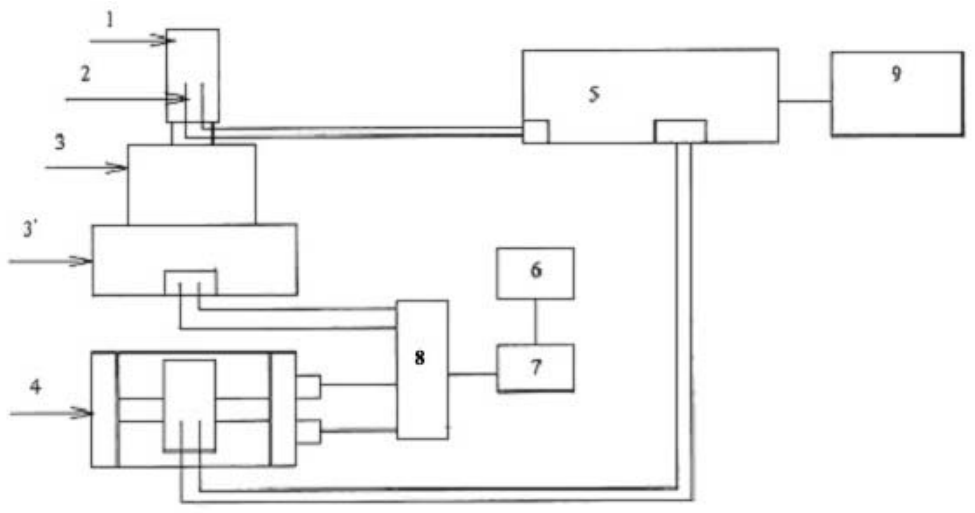
FIGURE 1 . The setup for treatment of DW by LF EMF and ELFV. (1) Glass test tube with diameter 10 mm and volume 10 ml, (2) platinum electrodes, (3) mobile part of the vibrator, (3 ′ ) motionless part of the vibrator, (4) the coil, (5) the device for the measurement of DW SEC (conductometer), (6) generator of sinusoid vibration, (7) the low-noise amplifier, (8) the switch (has two positions: I is EMF and ELFV and II is EMF), (9) personal